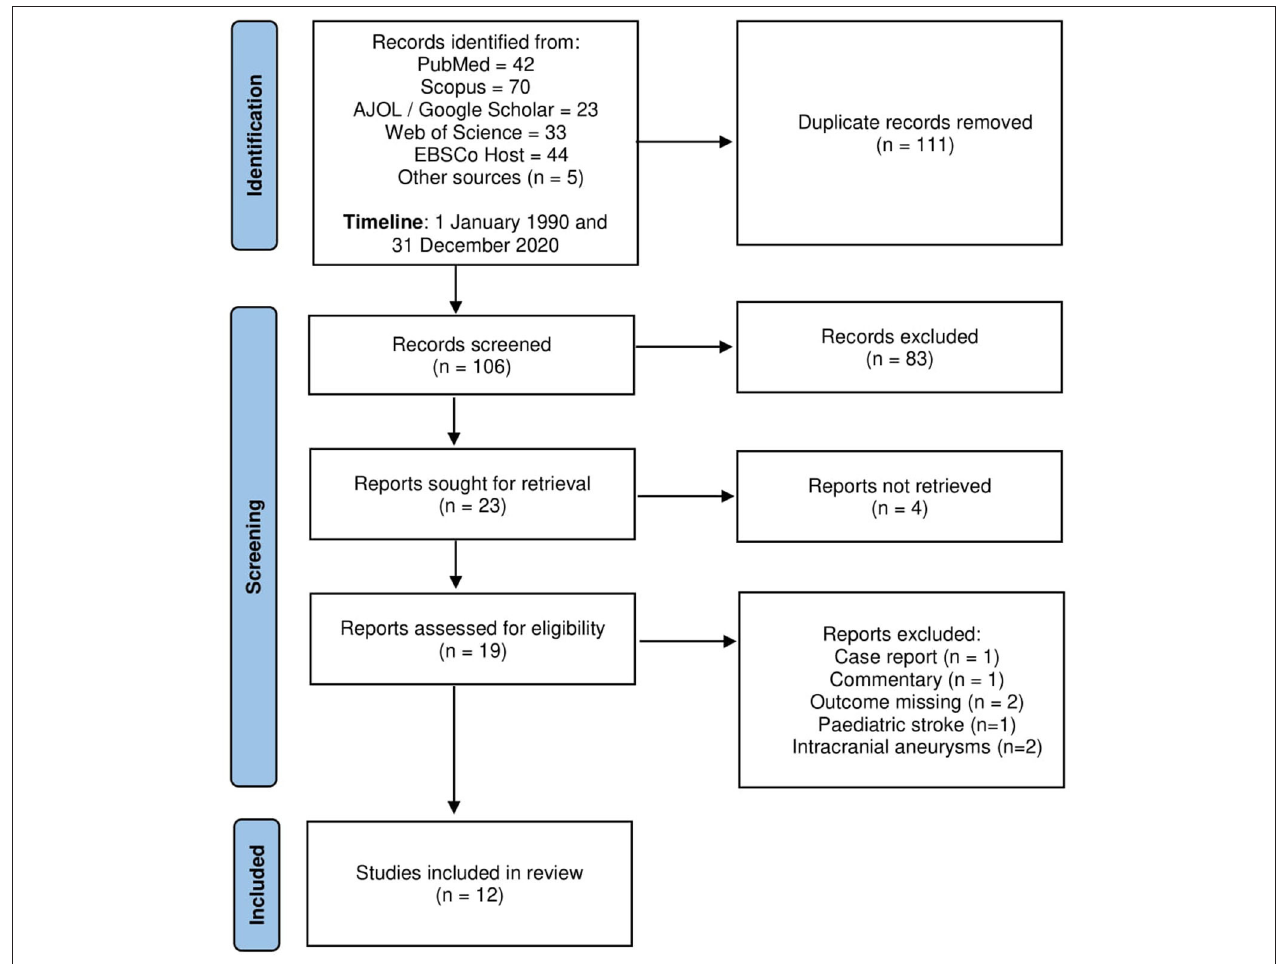
FIGURE 1 | PRISMA flow chart of selected